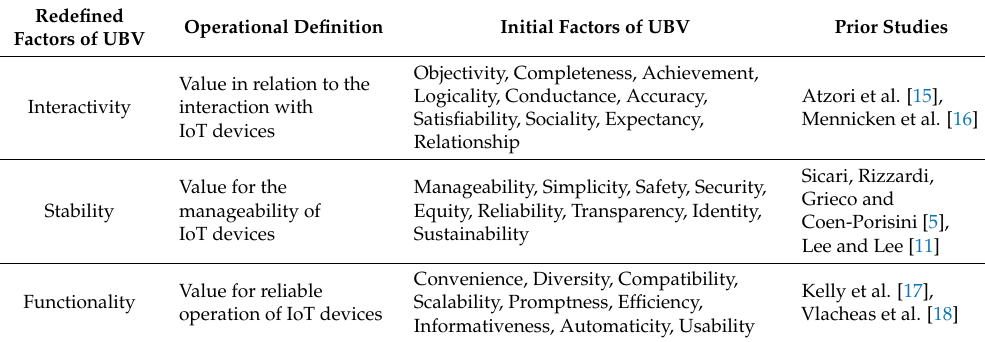
Table 2. Types of user behavioral value